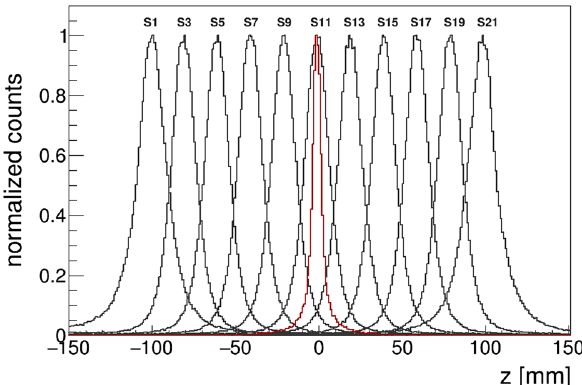
Fig. 4 Simulated geometrical acceptance of scintillators S1-S21 (only everyseconddetectorisshown)versus z -position.Shownisthenormal- ized probability that a positron from a μ + decay will be detected in the corresponding scintillator. For comparison, the geometrical acceptance of the T1 & T2 coincidence is also plotted (red line). The maximum of the efficiency for each detector was normalized to 1 to highlight the different geometrical resolutions